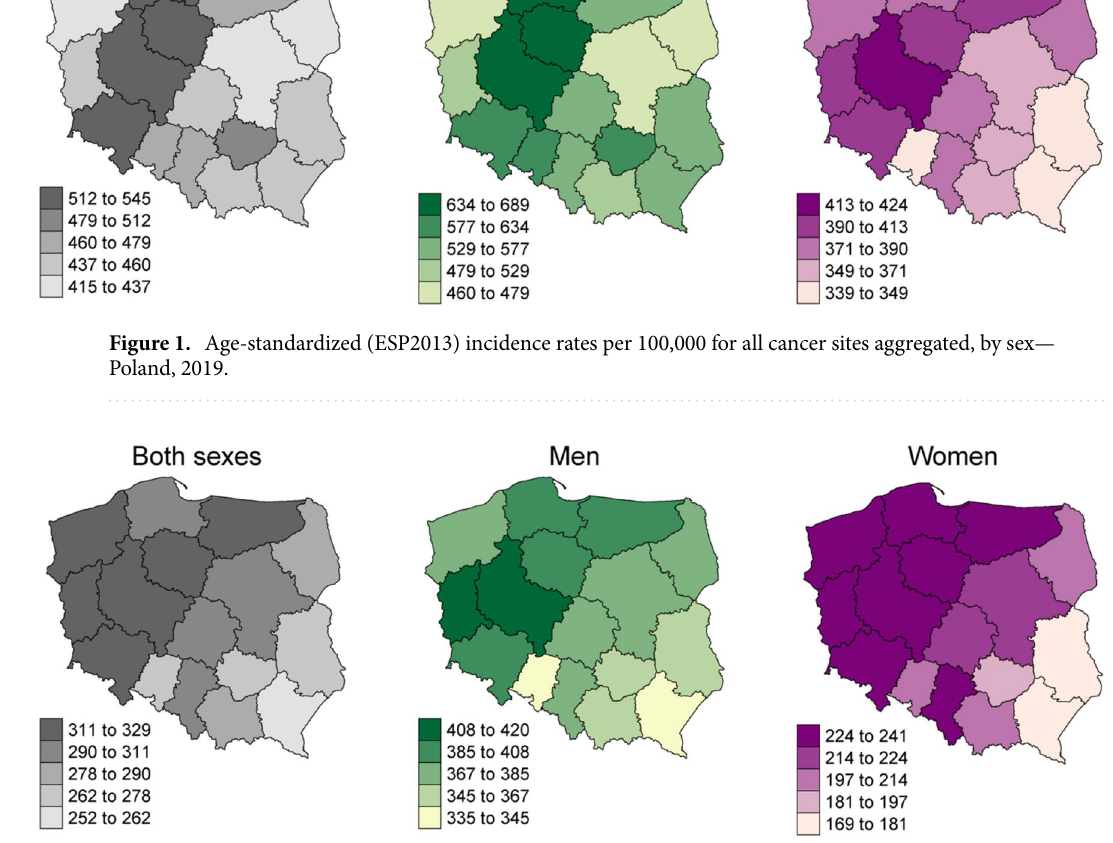
Figure 2. Age-standardized (ESP2013) mortality rates per 100,000 for all cancer sites aggregated by sex— Poland,